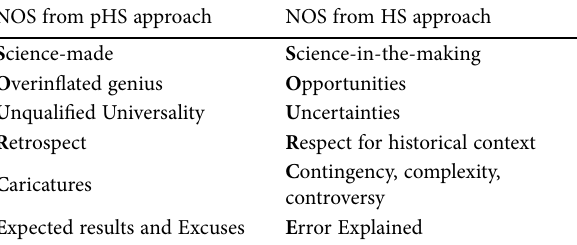
Table 2. Main features of NOS according to the SOURCE approach, based on Allchin (2003). 18 Every letter in the word SOURCE corre- sponds to an attribute from pseudo-history of science (pHS) as well as to an attribute from history of science